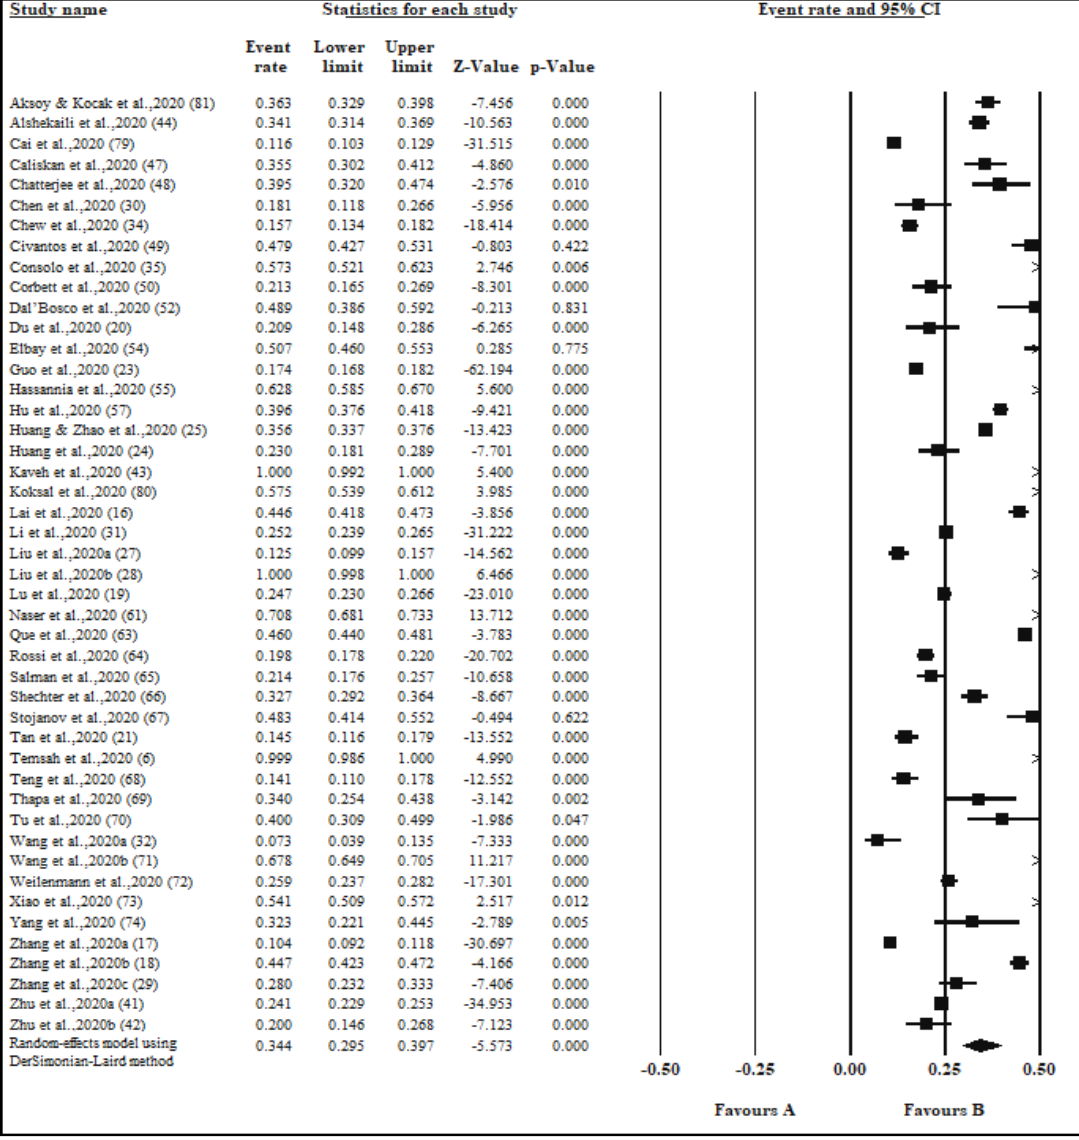
Figure 2. Forest plot for the studies on the prevalence of anxiety among healthcare workers. The squares and horizontal lines correspond to the study-specific event (anxiety) rates and 95% confidence intervals (CIs). The diamond represents the pooled prevalence and 95% CIs of the overall population. The overall pooled anxiety using a random effects DerSimonian-Laird method was 34.4% (95% CI: 29.5–39.7).